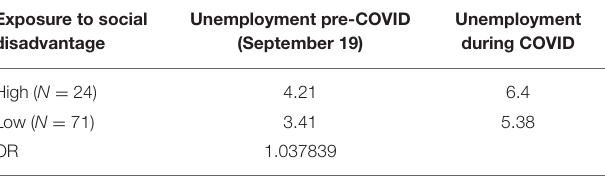
TABLE 4 | Odds ratio of unemployment for counties with high and low disadvantage. Exposure to social